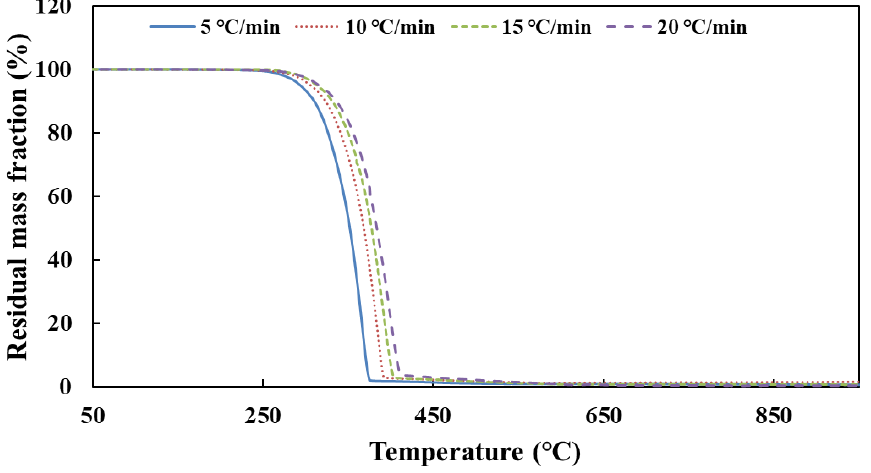
Figure 4. The TG curves of CYA pyrolysis at different heating rates.